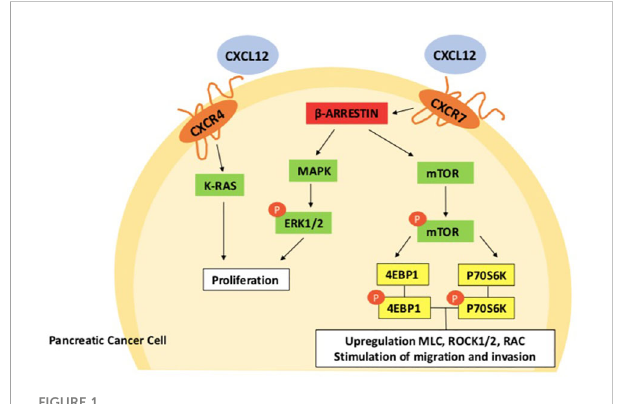
FIGURE 1 CXCL12-CXCR4-CXCR7 axis in pancreatic cancer cell. After